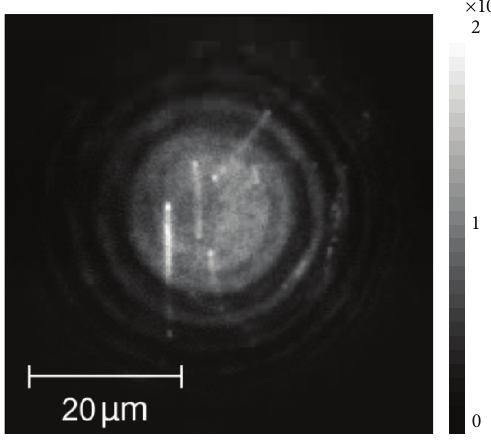
Figure 7: Wide-field fluorescence image of the PCP complexes mixed with AgNWs. The excitation wavelength and PCP concen- = 405 nm and 2 × 10 −3 mg/mL, respectively. tration were 𝜆 exc